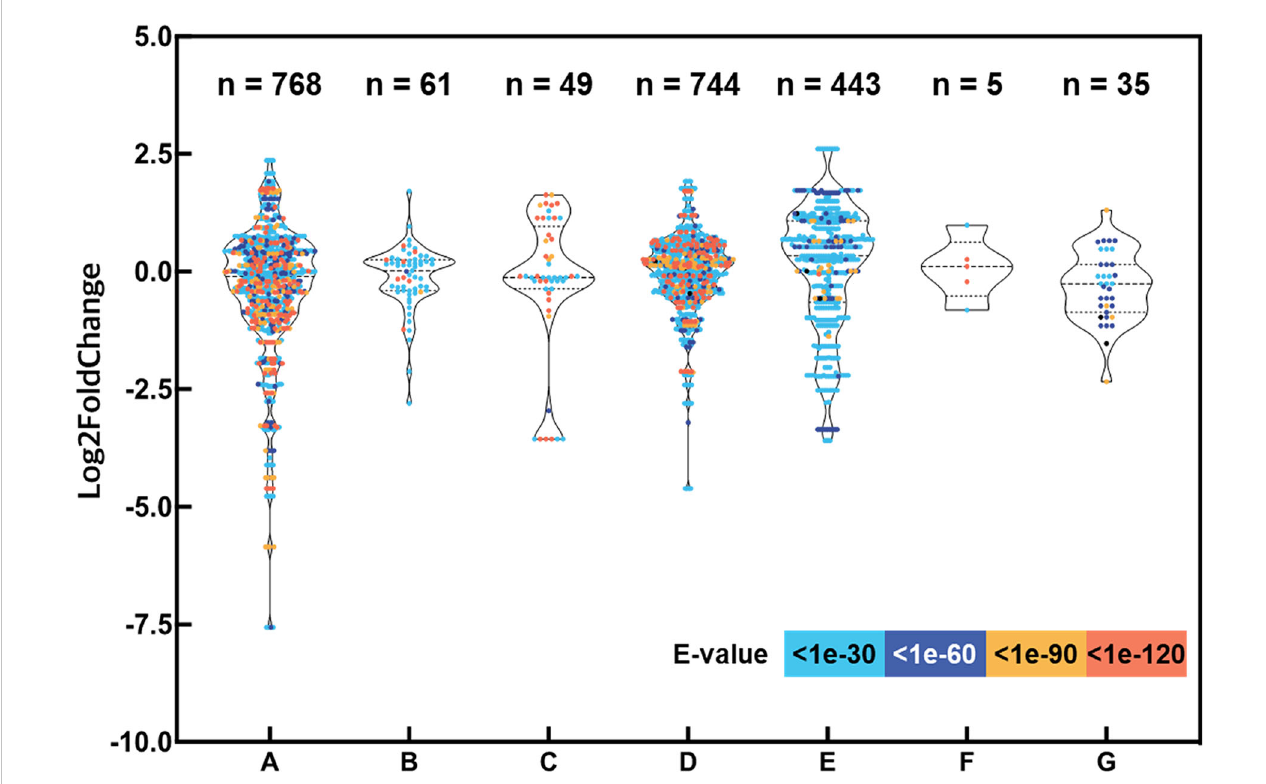
FIGURE 2 Expression levels of transcripts aligned with the drought-responsive genes by the seven categories and evaluation of the homology between the protein sequences encoding drought-responsive genes. The y-axis shows log2 fold change of each transcript and the x-axis indicates the gene categories shown in Supplementary Table S3: (A) ABA signaling, (B) Phosphorylation, (C) Osmotic stress sensing, (D) MAPK and Calcium signaling, (E) Transcription factors regulating gene expression during drought stress, (F) Epigenetic regulation, and (G) Drought stress-inducible genes encoding functional proteins. The number of hits (E-value < 1e-30) are shown at the top of the fi gure. The dots are displayed in different colors based on E-values from the homology